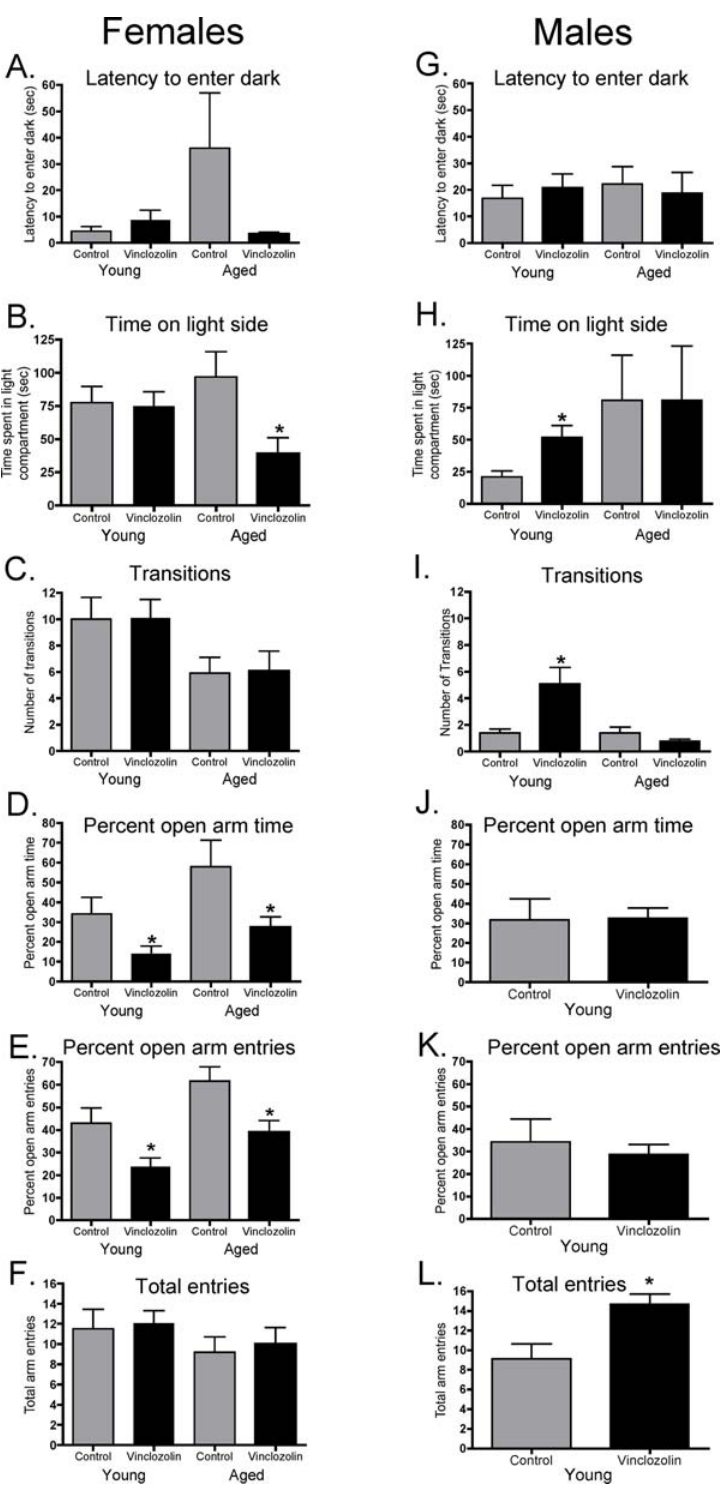
Figure 4. Performance in the light:dark box in young and aged third-generation female and male rats. Data are mean 6 SEM of latency to enter dark (A, G), time spent in the light side of the box (B, H) and the total number of transitions made between the light and dark sides of the box (C, I) in young (left panel) and aged (right panel) control and vinclozolin generation rats. For young and aged female rats N=8–9/group. For B aged: t 15 =2.65, p , 0.018. * P , 0.05, compared with control. Performance in the elevated plus-maze in young and aged third-generation female and male rats. Data are mean 6 SEMof percentopenarmtime (D, J), percent openarmentries (E, K)andtotalentries (F, L)in young(leftpanel)andaged (rightpanel)control and vinclozolin generation rats. For young rats, all animals from above are shown; for aged rats, N=5 (control) and 7 (vinclozolin). The aged group represents a subset of those run in the light:dark box shown because of technical (unstable lighting) conditions during testing for the first 5 rats; these rats were omitted from the analysis. For D young: t 15 =2.30, p , 0.036. For E young: t 15 =2.51, p , 0.024. For D aged: t 10 =2.40, p , 0.037. For E aged: t 10 =2.82, p , 0.018. *P , 0.05, compared with control. For young male rats, N=9–12/group. For aged male rats, N=9–10/group. For H young:t 19 = 2 2.65, p , 0.016. For I young: t 19 = 2 2.46, p , 0.024. * P , 0.05, compared with control. All young male animals L: t 19 = 2 3.32, p , 0.004. *P , 0.05, compared with control. doi:10.1371/journal.pone.0003745.g004 PLoS ONE |